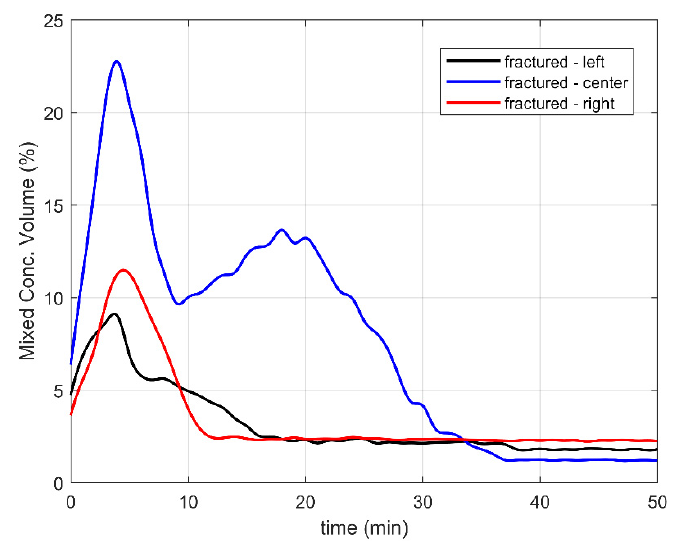
Figure 8. Transient experimental values of mixed concentration volume fraction (saltwater concen- tration between 25% and 75%) obtained for the three laboratory aquifers during the saltwater retreat phase. Critical water abstraction, Q = 0.5 mL/s (red), Q = 0.8 mL/s (blue) and Q = 1.1 mL/s (black), was terminated at t = 0 s.